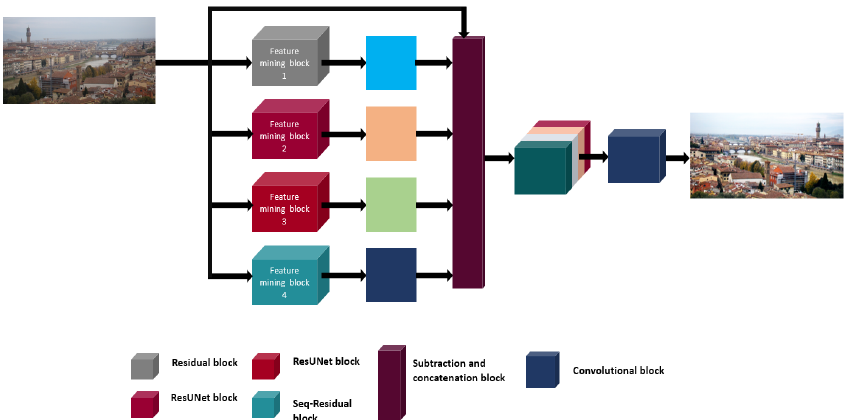
Figure 1. The above diagram shows a schematic of the proposed Deep dehaze network. First, the hazy input image is fed into the four feature extraction blocks. These blocks extract the haze information from the input image. Then, these features are subtracted from the input image. The four different resultants are concatenated, and concatenation is followed by a convolution operation. This convolution operation provides the final output dehazed picture. Here, different colors for the Res-U-net module indicates different numbers of filter parameters.